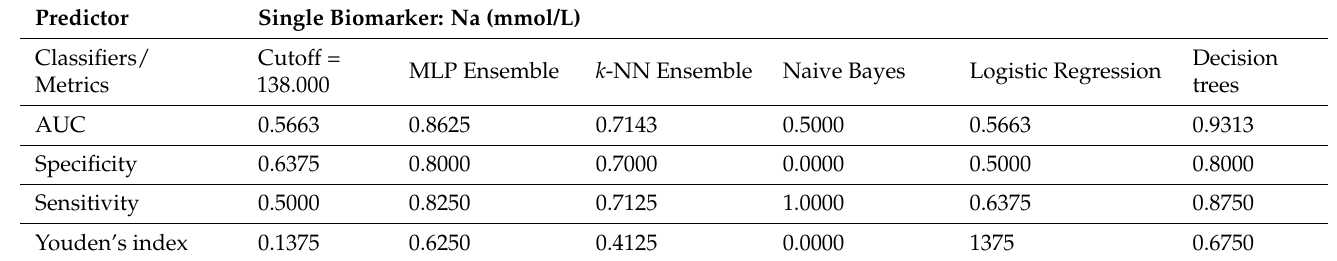
Table 5. The diagnostic performance of six classifiers for predicting CRS by using single predic- tive variable: sodium concentration Na (mmol/L). Metrics of performance are: AUC, Specificity, Sensitivity and Youden’s index.